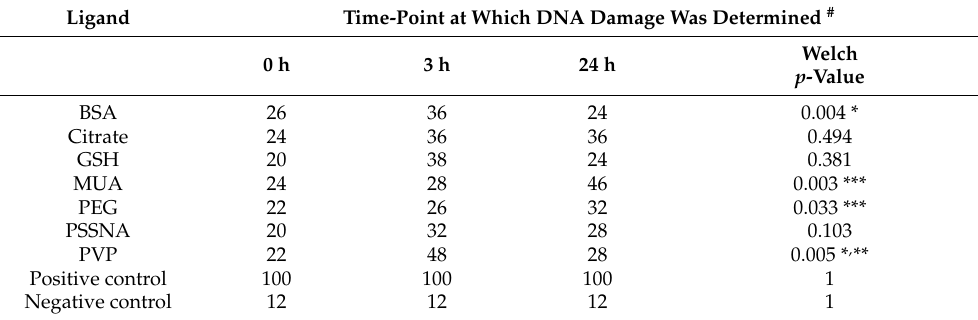
Table 3. Overall percentage of DNA damage induced by the GNP-ligands.